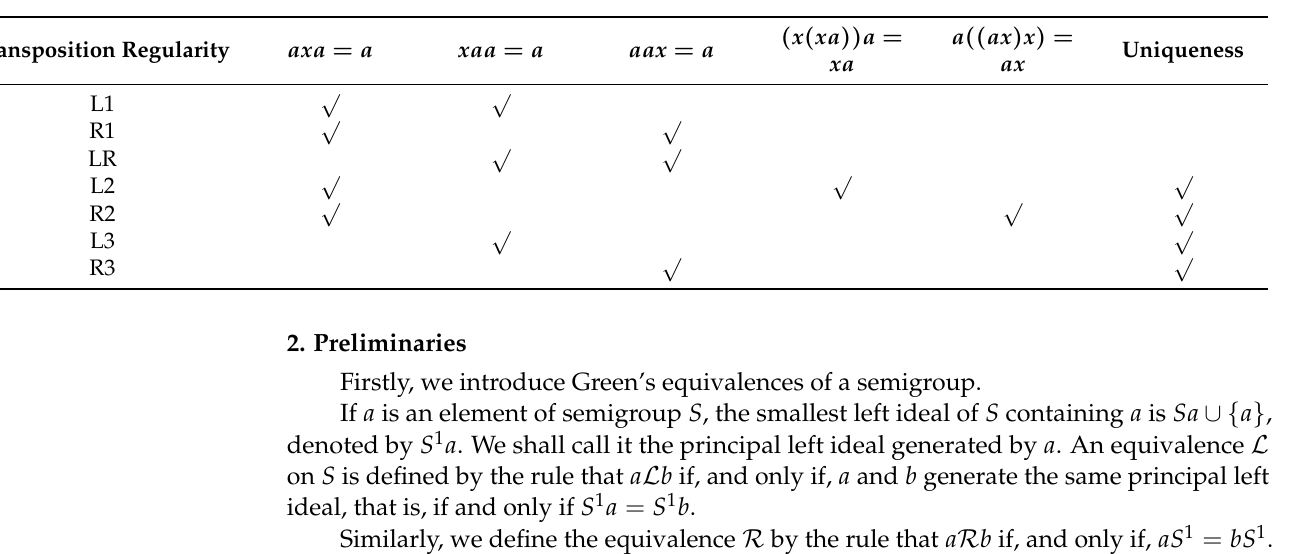
Table 1. These are various transposition